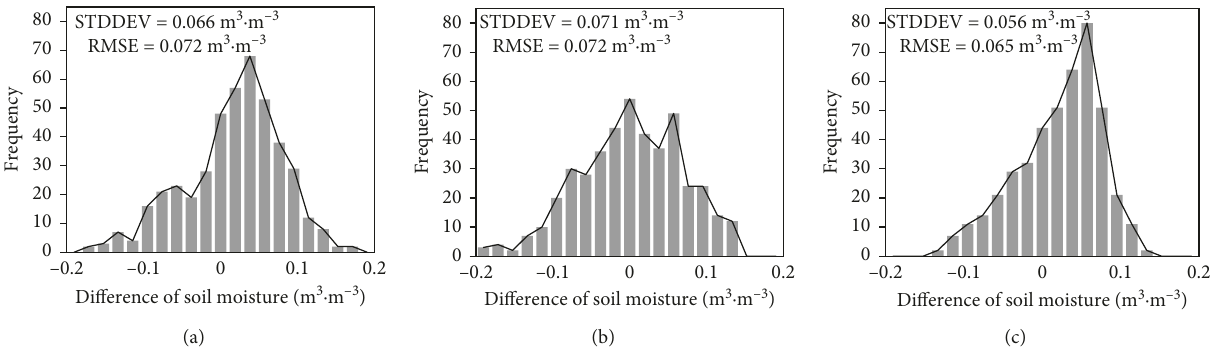
Figure 5: Histograms of the difference between remotely sensed SM such as (a) 12.5km ASCAT SM, (b) 1km ASCAT SM (polynomial), and (c) 1km ASCAT SM (SVR) and in situ SM